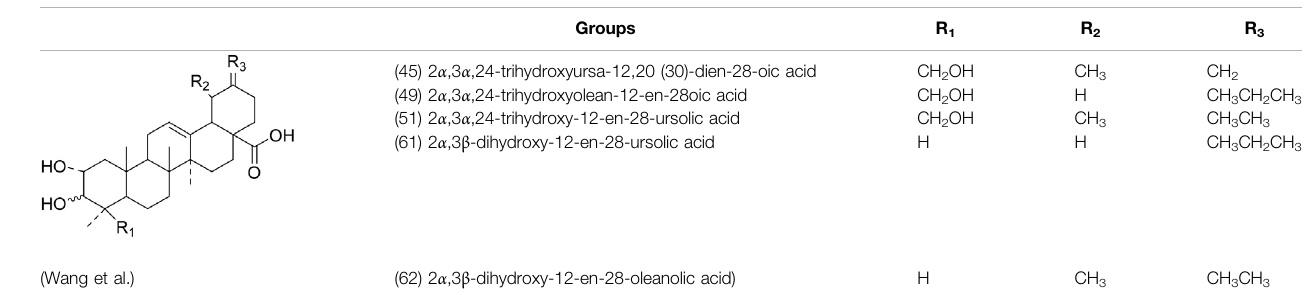
TABLE 3 | Chemical structures of triterpenes isolated from PVL ─ Part III.